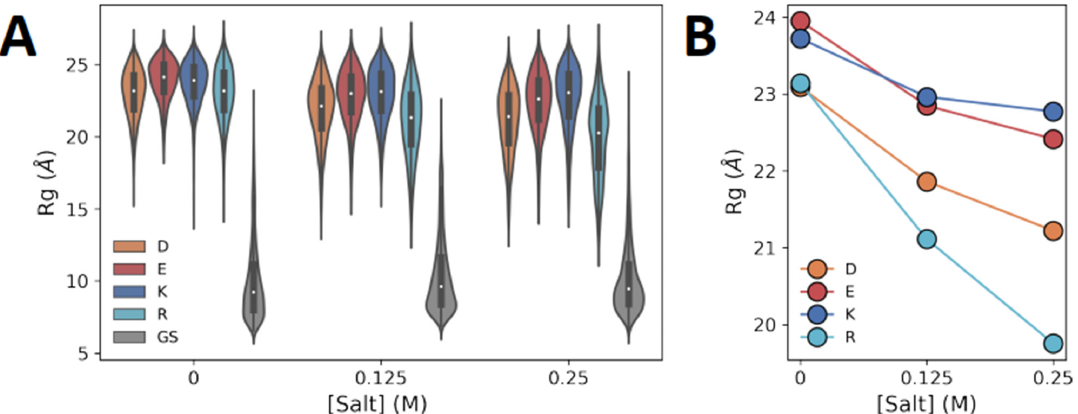
Figure 2. Dimensions of charged homo-polypeptides. ( A ) Violin plots of the Rg values of polyD, polyE, polyK, and polyR polyelectrolytic polypeptides, each constituting 30 residues, at three NaCl concentrations: 0 M, 0.125 M, and 0.25 M. The simulations at 0 M salt concentration included counterions to neutralize the charges of the homo-polypeptides. A polypeptide with 15 GS repeats was also simulated, as a control. The violin plots are colored according to amino acid identity, as indicated by the key. ( B ) Mean Rg of each charged homo-polypeptide as a function of NaCl